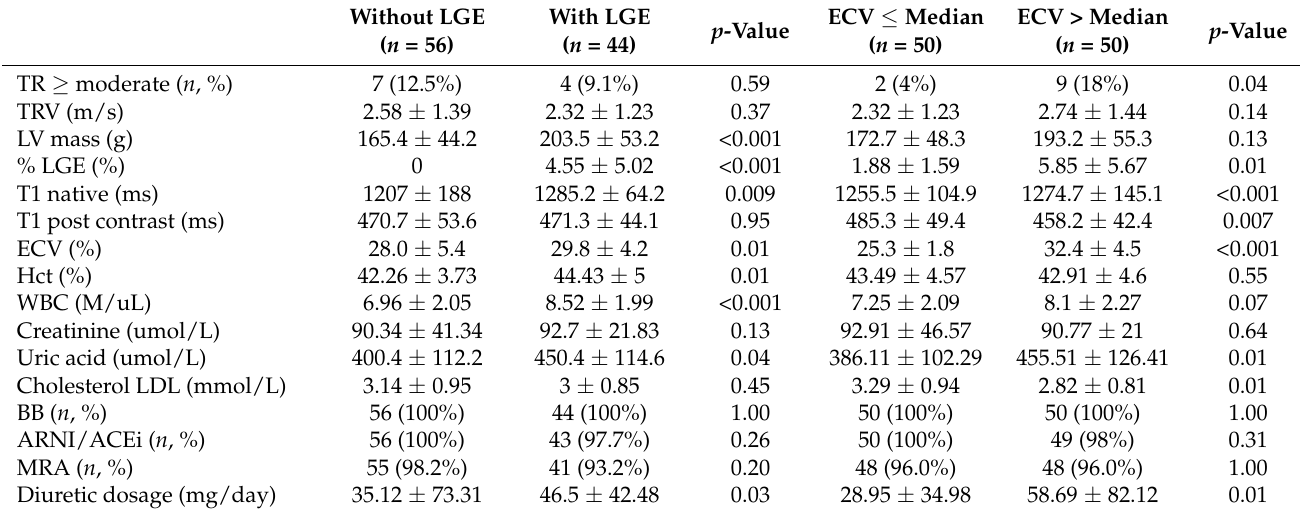
Table 2. Comparison of biomarkers between DCM patients, stratified according to LGE and ECV.